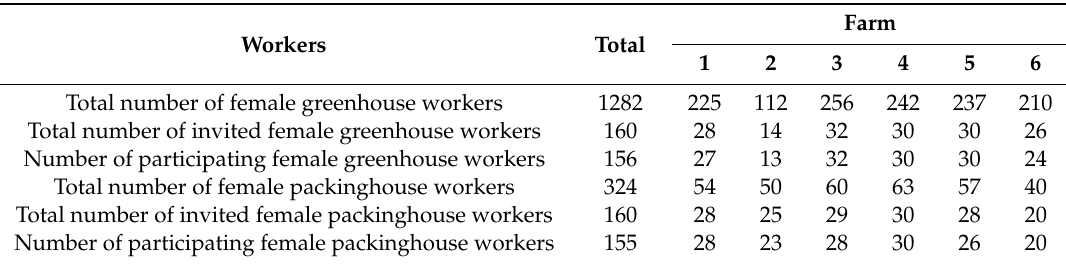
Table 1. Numbers of invited and participating female workers from six randomly selected flower farms in Ethiopia, 2017. Workers